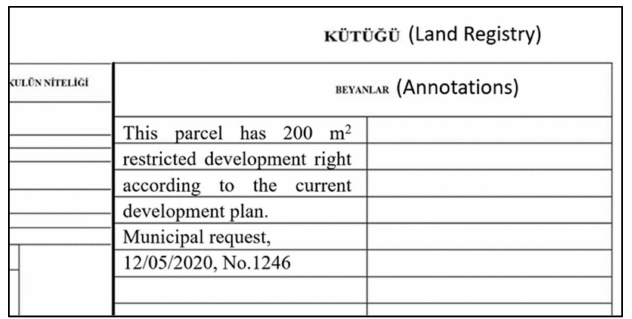
Figure 10. Putting annotation on the title in the land registry book (only the relevant part of the registry book is shown and the given date and registry number are random).